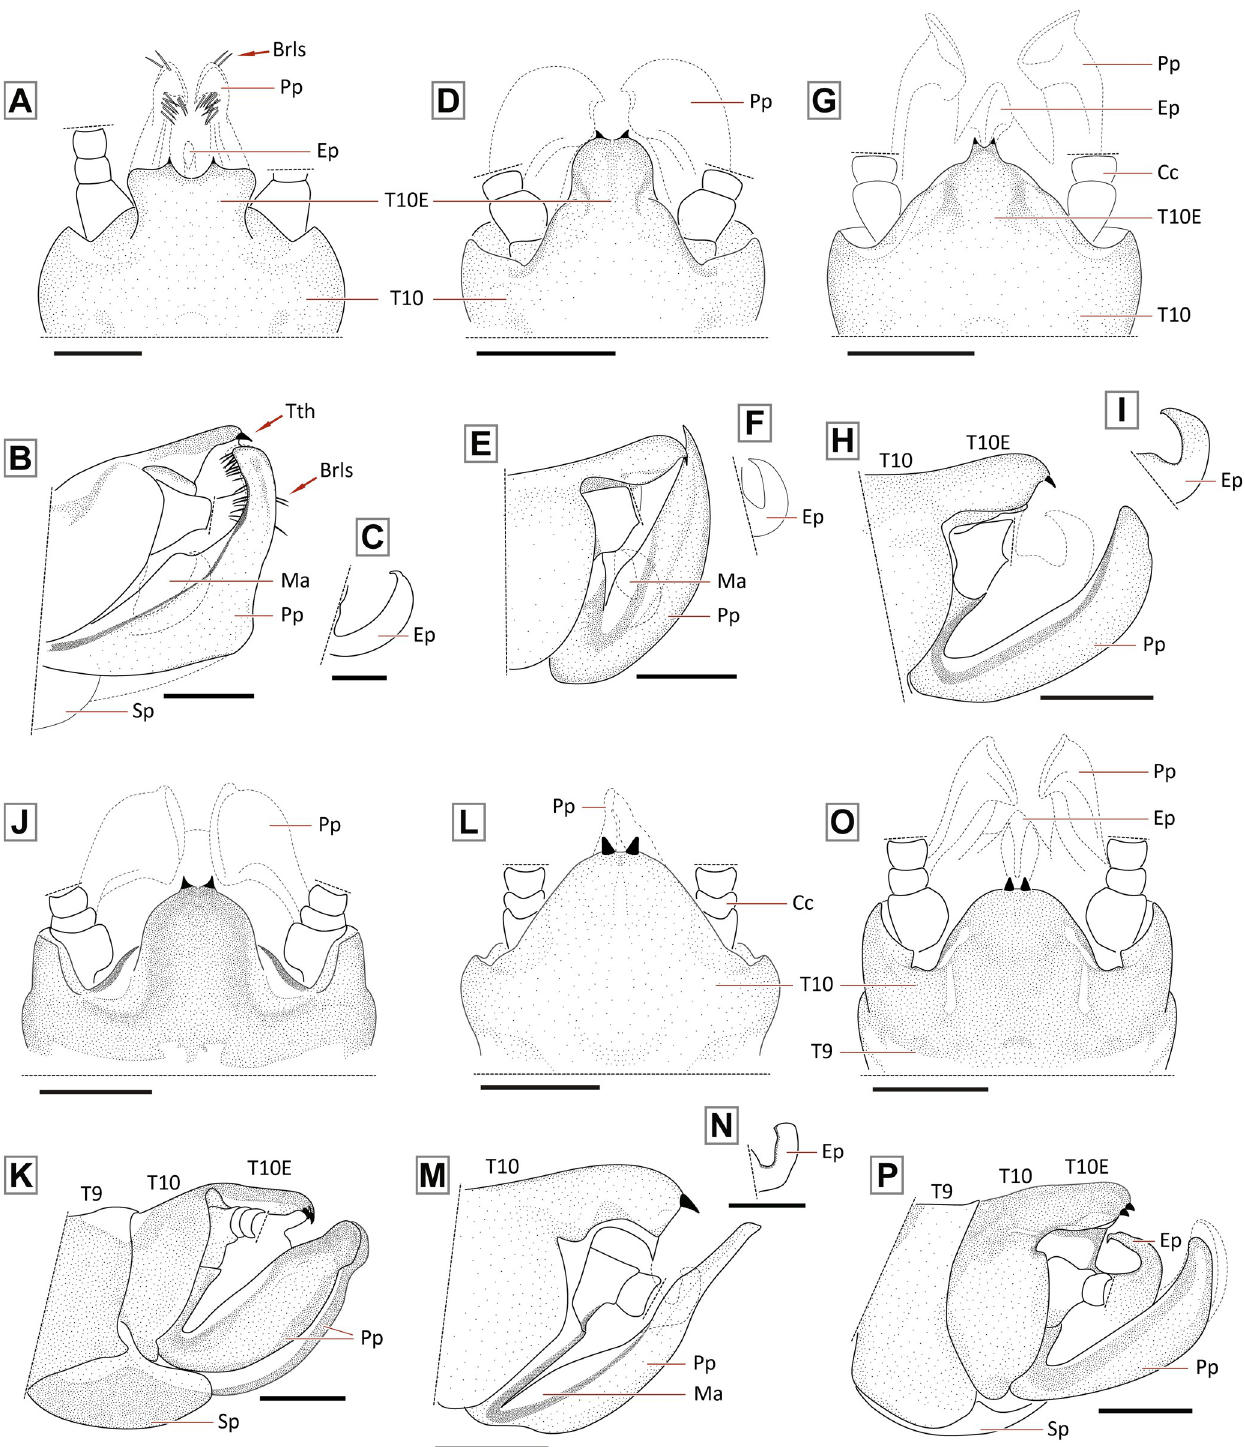
Fig 8. Male terminalia of the Paragripopteryx species. Paragripopteryx anga : (A) male holotype, partial T10 in dorsal view. (B , C) Male holotype, paraprocts and detail of epiproct in lateral view, respectively. Paragripopteryx blanda : (D) male specimen from Santa Catarina state, T10 in dorsal view. (E , F) Paraprocts and epiproct in lateral view, respectively. Paragripopteryx delicata : (G) male holotype, T10 in dorsal view. (H , I) : Paraprocts and epiproct in lateral view, respectively. Paragripopteryx egena : (J) male T10 in dorsal view. (K) Paraprocts in lateral view. Paragripopteryx guardae : (L) male holotype, T10 in dorsal view. (M , N) Paraprocts and detail of epiproct in lateral view, respectively. Paragripopteryx hamata : (O) male holotype, T10 in dorsal view. (P) Paraprocts and epiproct in lateral view (Scale bar: 0.2 mm).